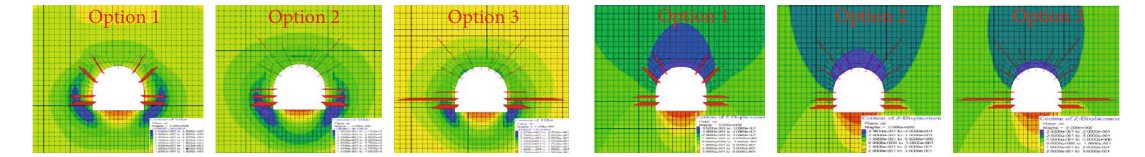
Figure 4: Stress variation and vertical displacement of roadway surrounding rock under di ff erent support schemes [29, 30].